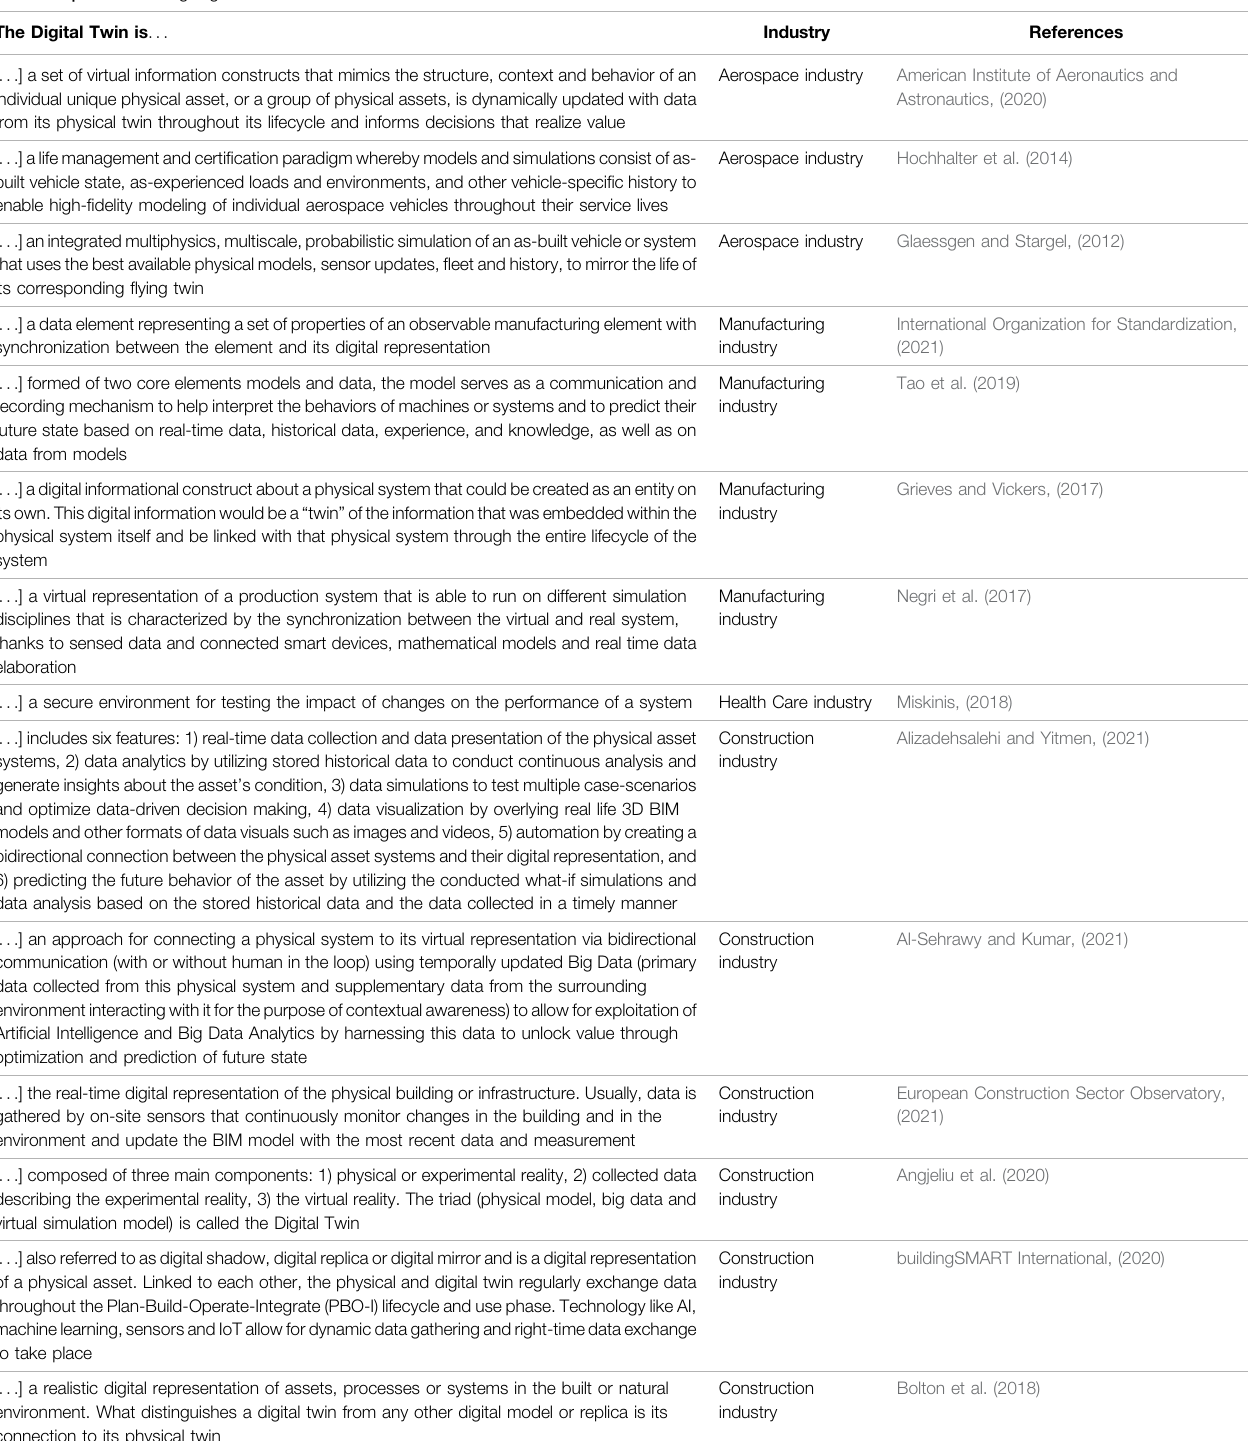
TABLE 2 | List of existing Digital Twins de fi nitions in different